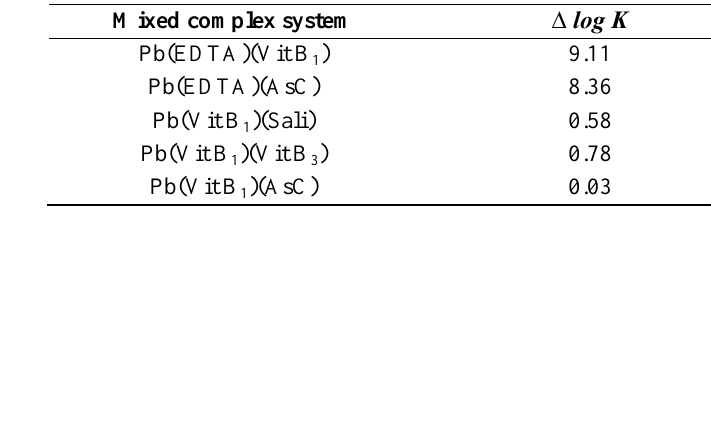
Table 3 : Δ log K values obtained for mixed